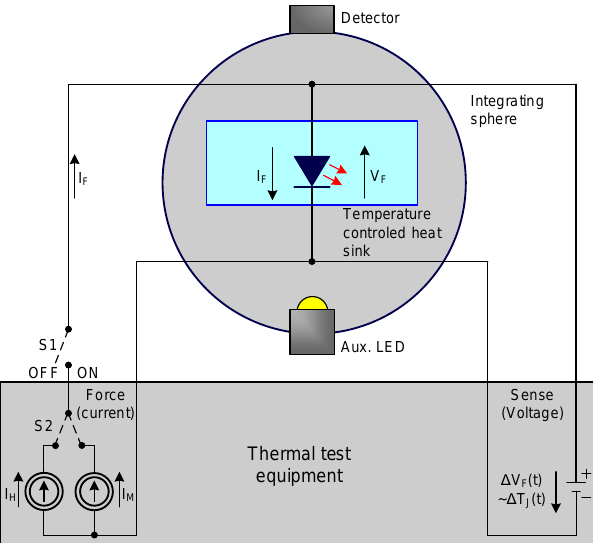
Figure 1. Diagram of a combined thermal and radiometric light emitting diodes (LED) testing station [15].